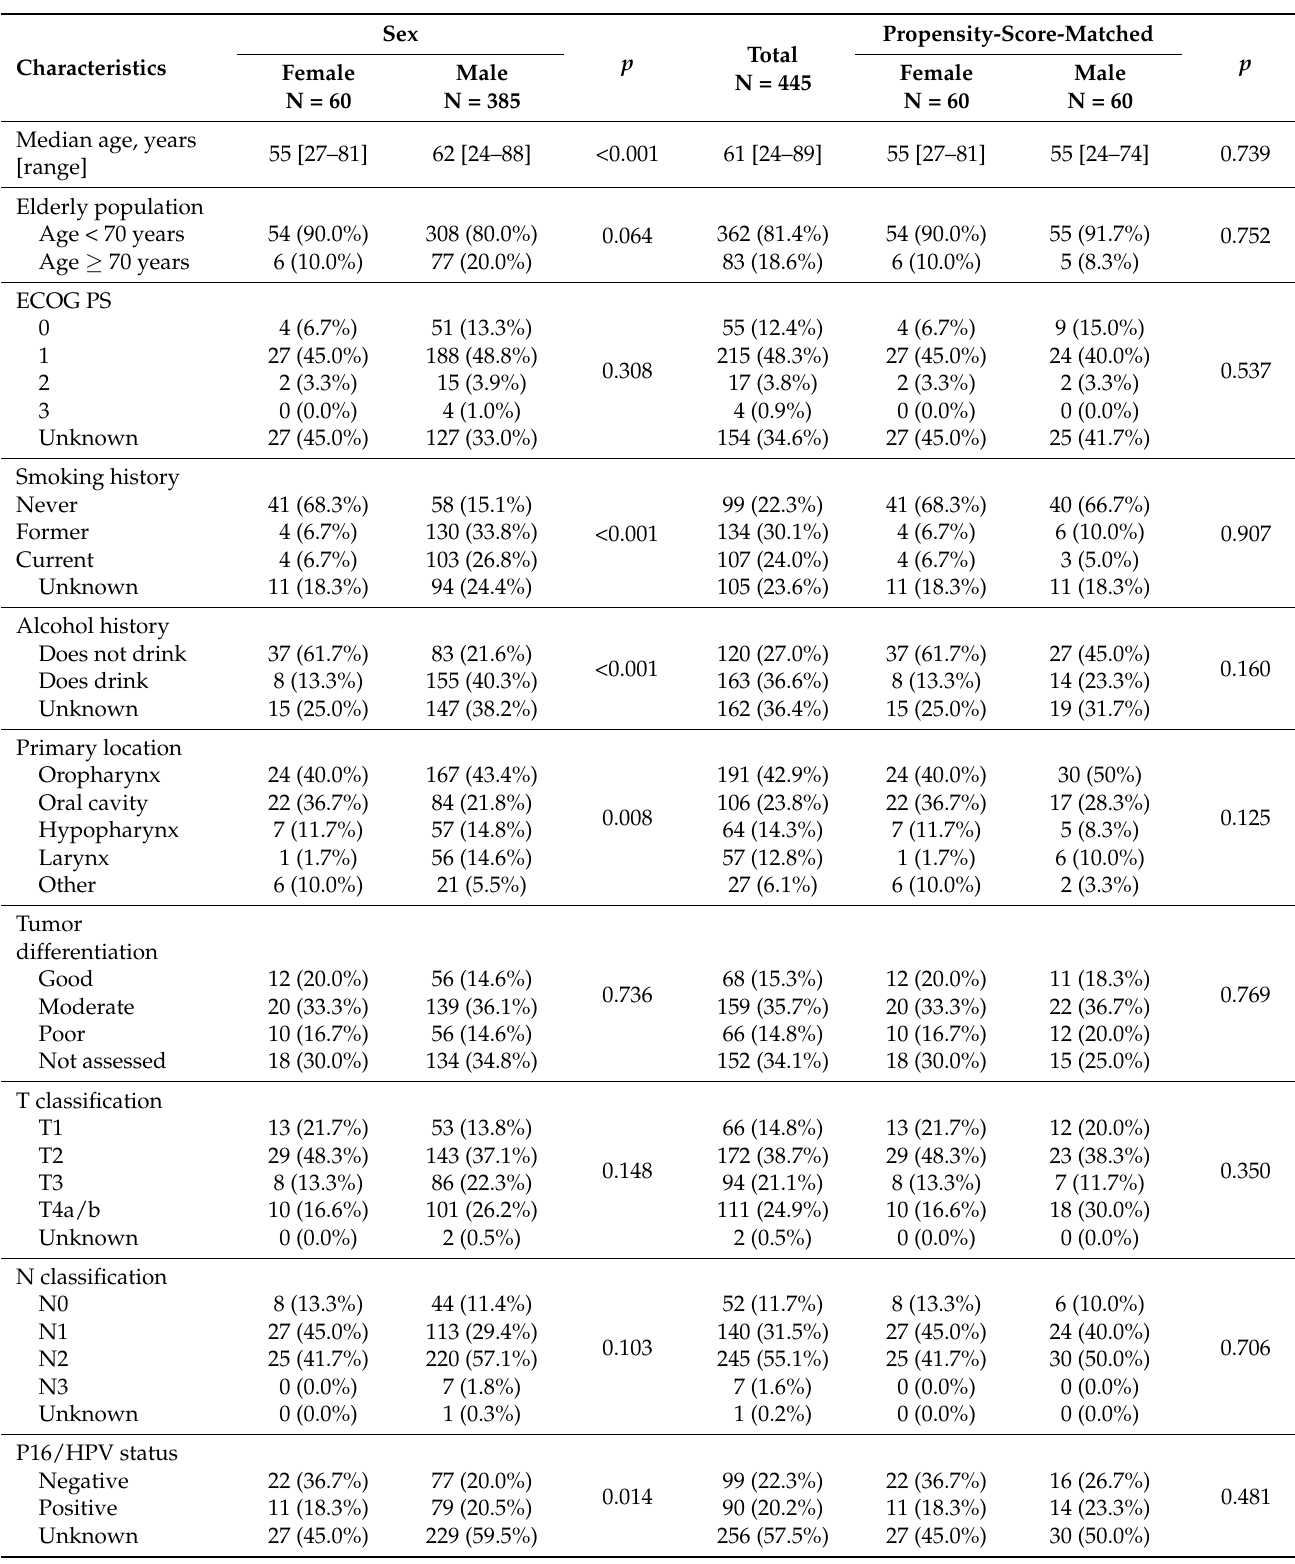
Table 1. Baseline characteristics of locally advanced head and neck squamous cell carcinoma by